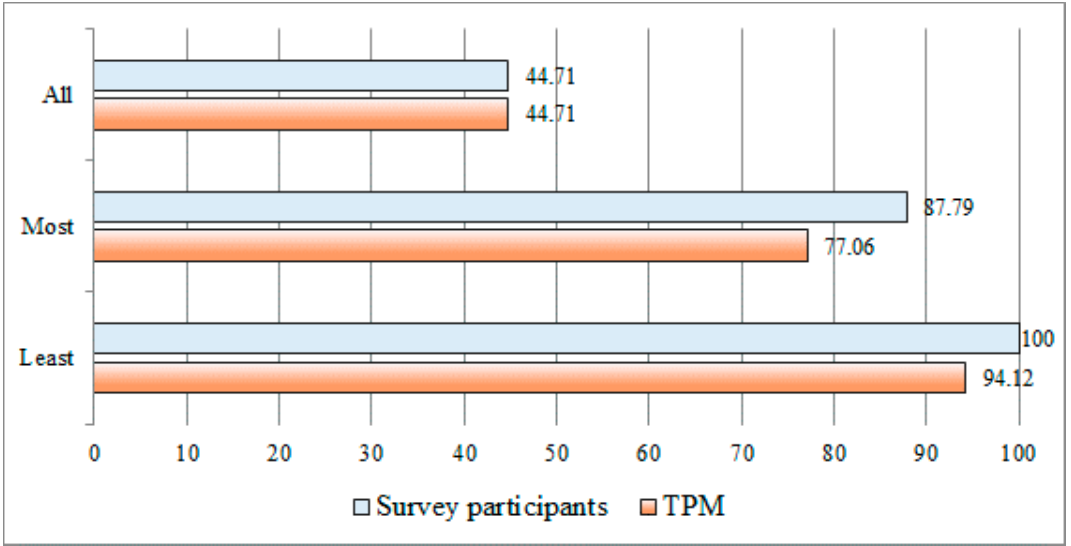
Figure 12. Comparison of the emotion match rates.